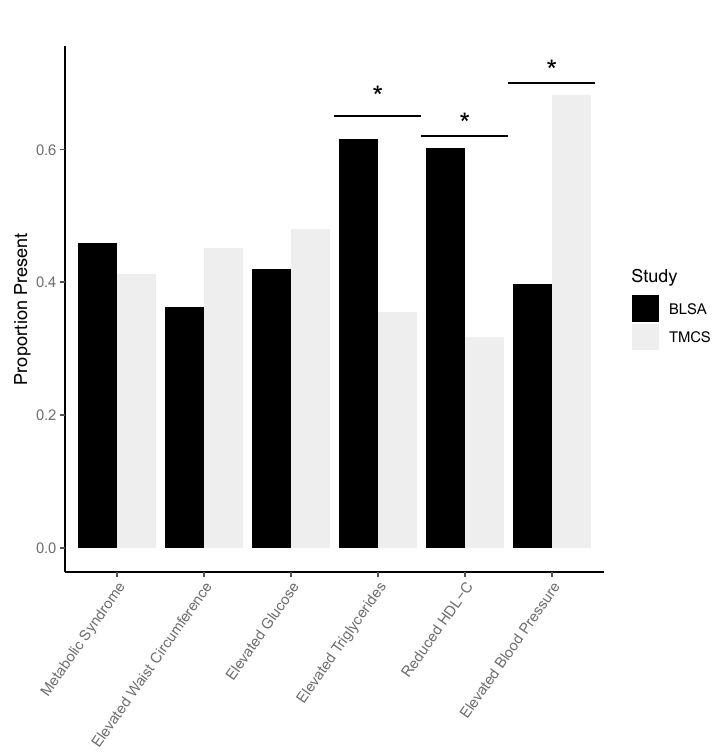
Figure 1. Distribution of metabolic syndrome (MetS) and individual MetS risk factors in each cohort. * indicates a significant difference at p <0.05 between risk factor prevalence in BLSA compared to TMCS according to chi-square tests. BLSA: Baltimore Longitudinal Study of Aging; TMCS: Tsuruoka Metabolomics Cohort Study. Table 1. Participant demographics.